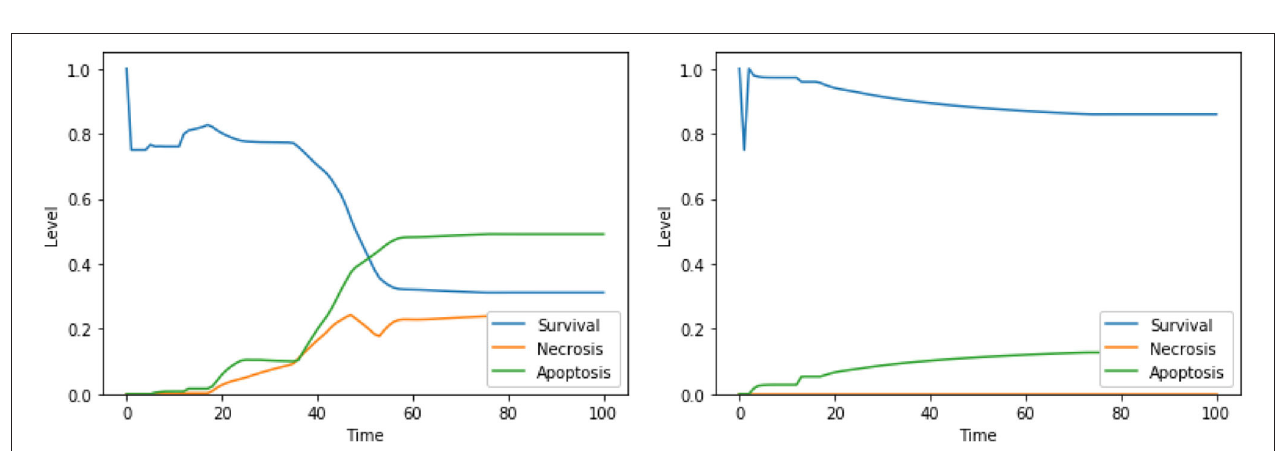
FIGURE 4 | Dynamics of the unperturbed DFM, in the case of low (left) and high (right) PKA